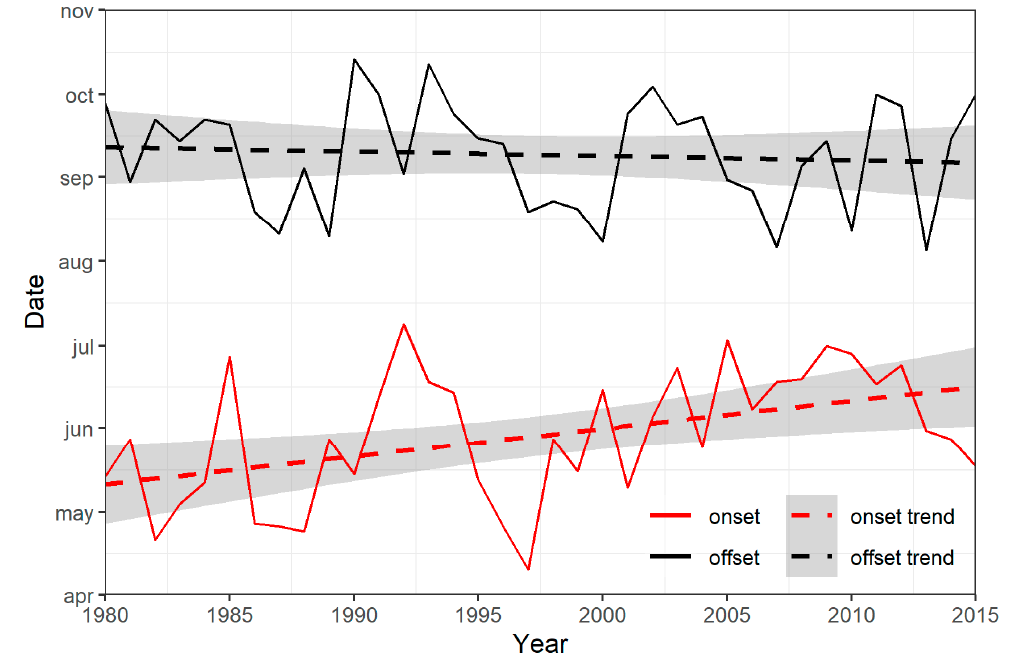
Figure 7. Interannual variability and trend of onset (in red) and offset (in black) days in Bangladesh Meteorological Department (BMD) observations for Khulna station.